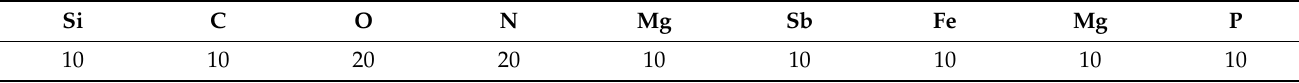
Table 1. Impurities content in Ni foils (ppm).